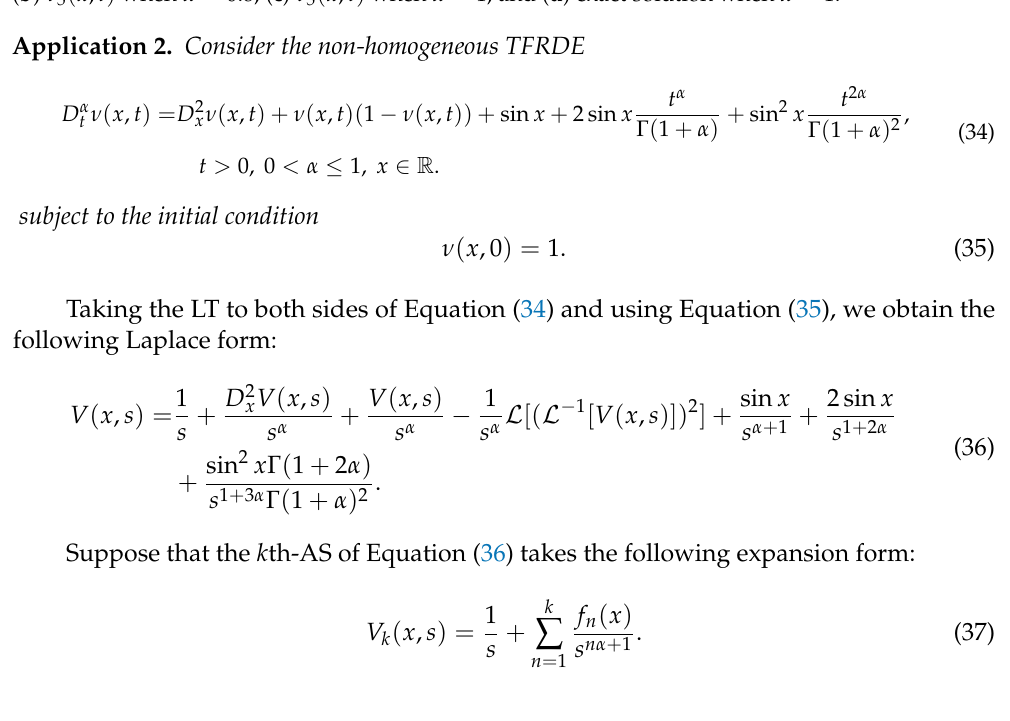
Figure 1. The surface graphs of the exact and ASs of Equations (17) and (18): ( a ) ν 5 ( x , t ) when α = 0.6, ( b ) ν 5 ( x , t ) when α = 0.8, ( c ) ν 5 ( x , t ) when α = 1, and ( d ) exact solution when α =